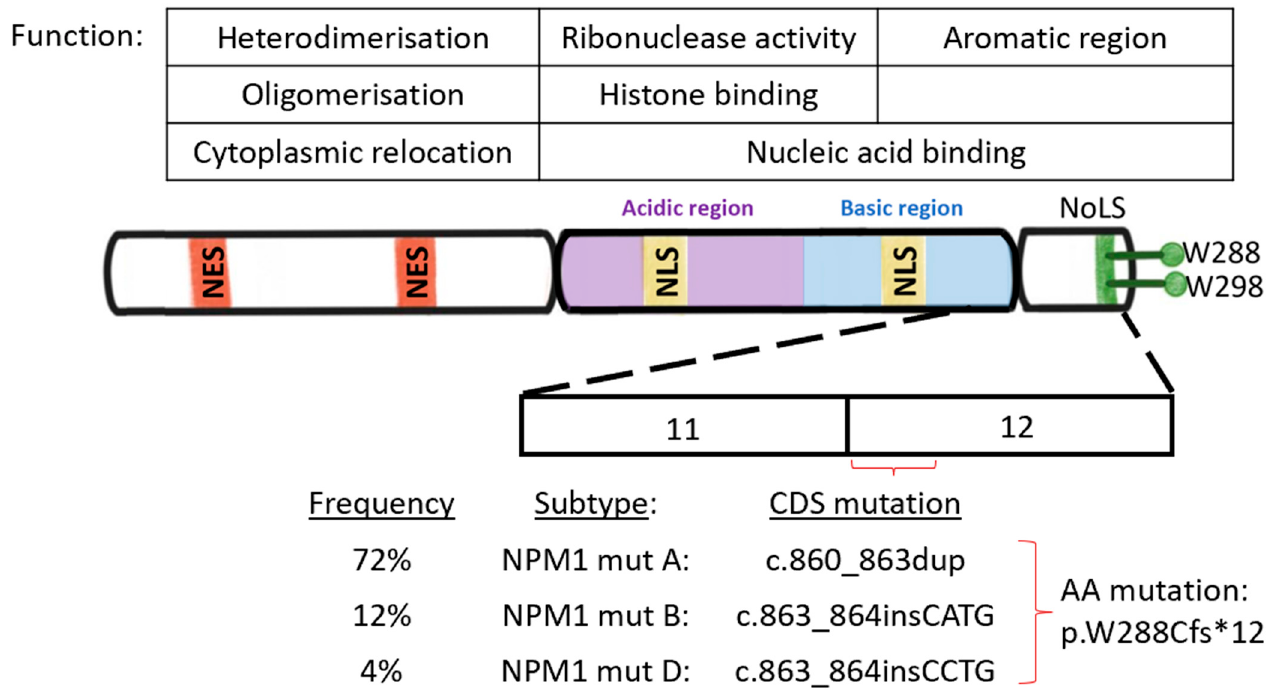
Figure 1. Genetic and functional characteristics of wild-type NPM1 protein. NES: Nuclear export signals, NLS: nuclear localisation signal, NoLS: Nucleolar localisation signal. Type A, B and D NPM1 mutations (denoted as NPM1-mut A, B, and D) with corresponding frequencies found in patients with NPM1 -mutated AML: CDS mutation (the change that has occurred in the nucleotide sequence) leads to a frameshift, therefore, abolishing tryptophan (W) W288 and W298 at the c-terminal domain (usually present in wild-type NPM1 protein). AA mutation: amino acid mutation of W288Cfs*12 (tryptophan 288 to cysteine frameshift at exon